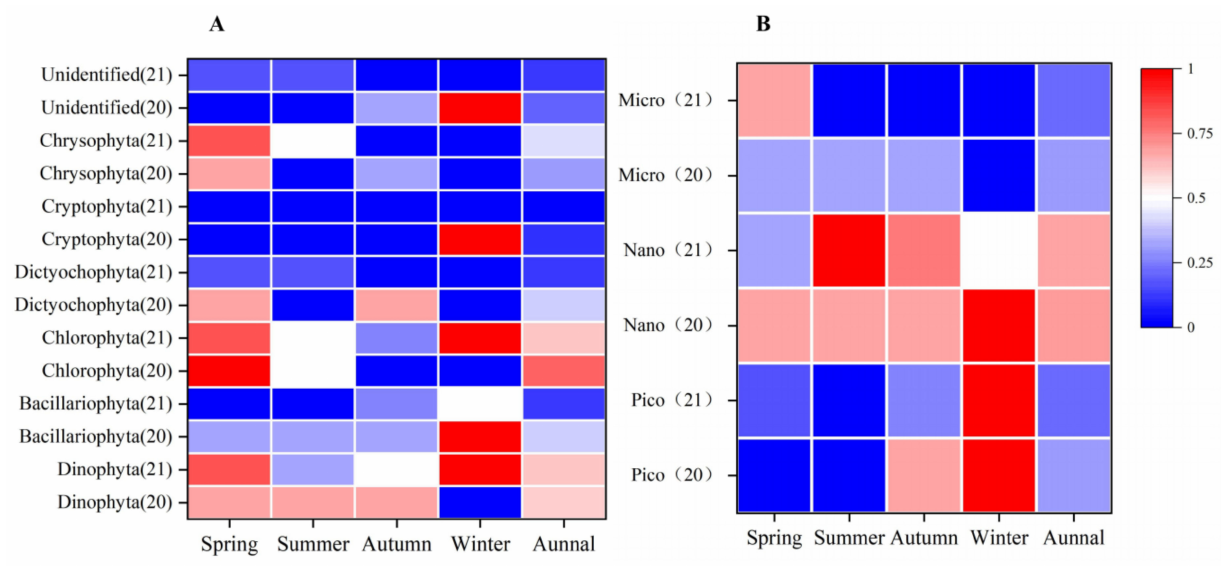
Figure 6. Frequency distribution of the situation of E values greater than 0: ( A ) various groups; ( B ) various